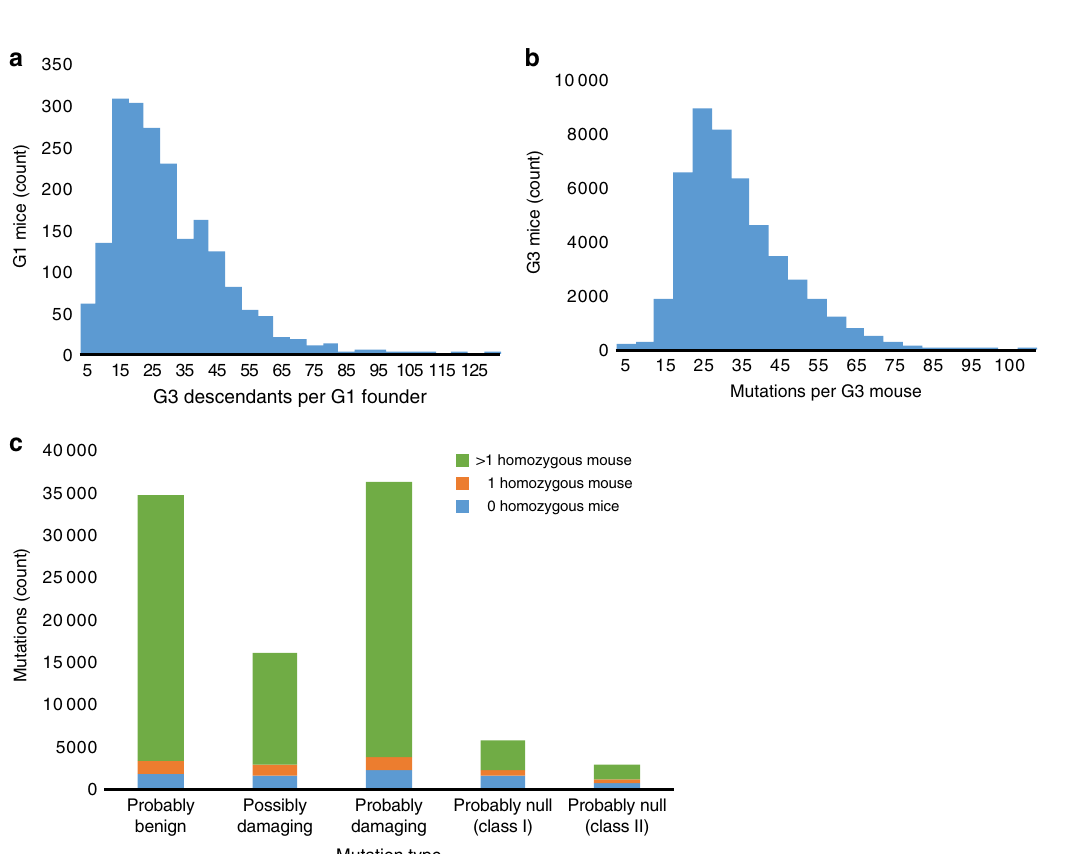
Table 1 Mutations analyzed in this study Mutation classi fi cation All mutations Isolated mutations Probably benign (score ≤ 0.45)